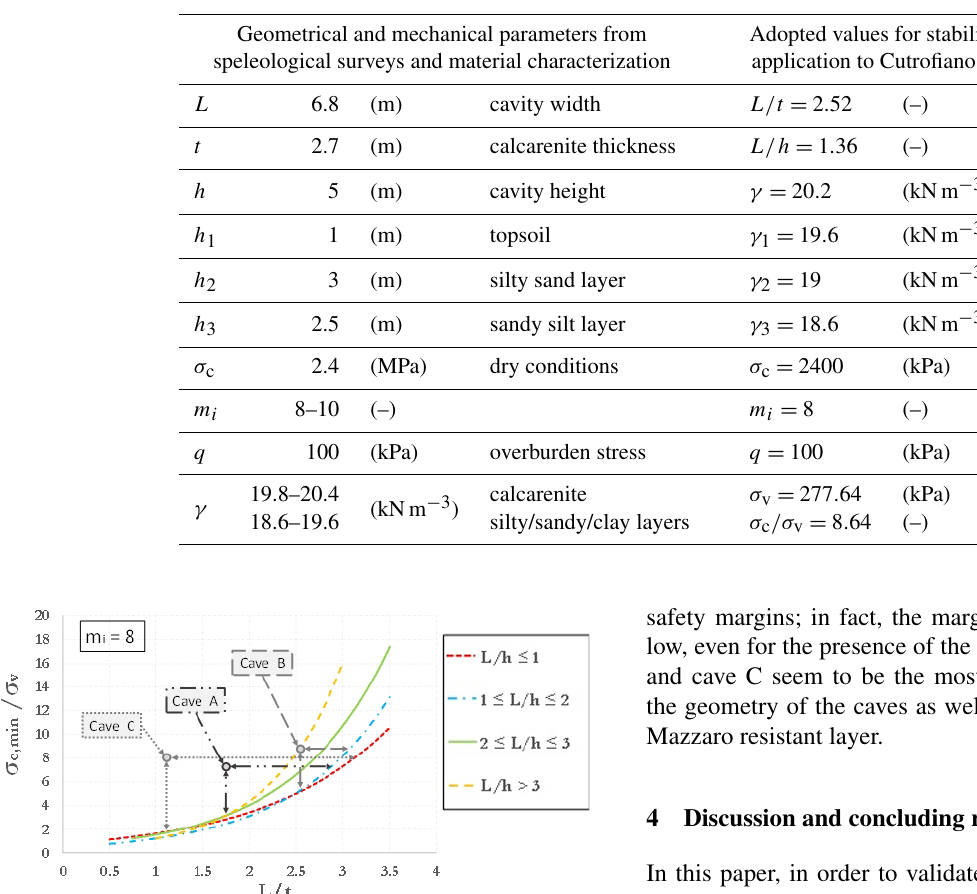
Table 6. Geometrical and mechanical parameters and adopted values for stability chart application to the underground Cutrofiano Cave B (Maglio and Ligori, 2014; Parise and Lollino, 2011).